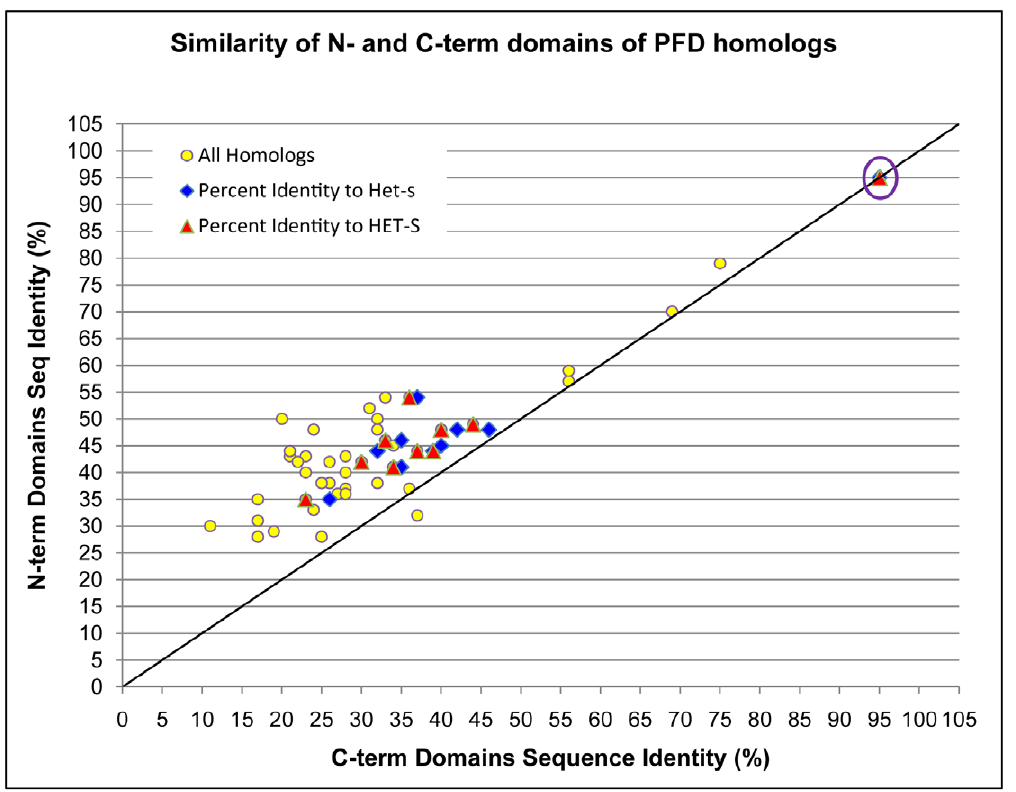
Figure 2. Graphical representation of the similarity matrix between N- and C-terminal homologs of the PFD. Each point on the graph represents the percent similarity of the C-terminal domains and the N-terminal domains for a pair of PFD homologs. In addition to HET-s, ten PFD homologs are represented. Pairs of homologs that include the HET-s or HET-S proteins have been colored differently for comparison. Comparison of Podospora anserina sequences to each other are circled (purple).